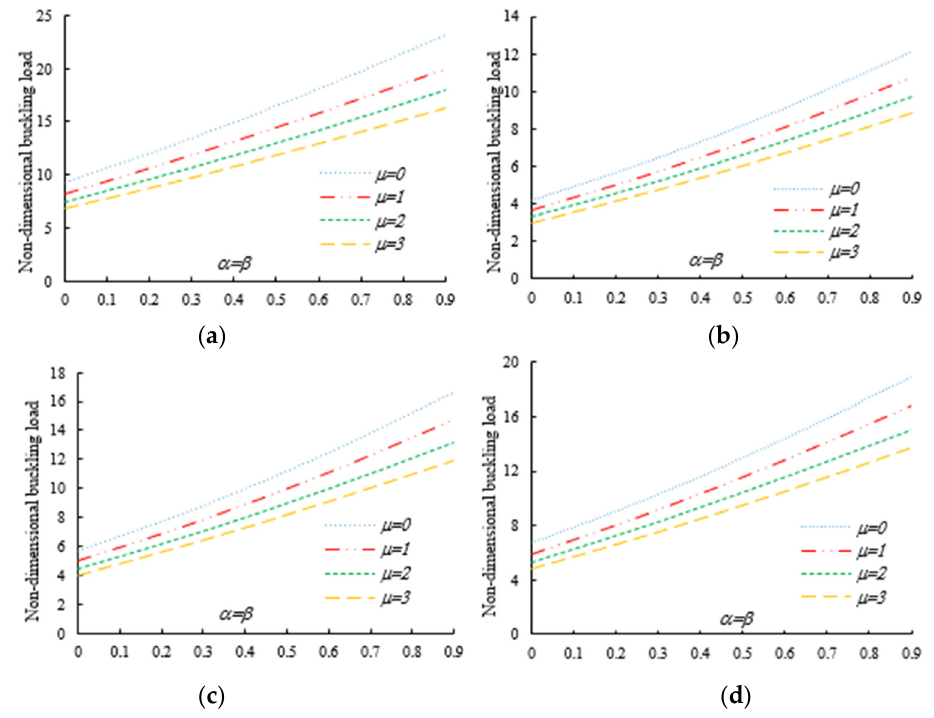
Figure 3. Variation in the flexural–torsional buckling load ( P nor ) of I-tapered nanobeams with varying tapering and nonlocality parameters—Figure 2. Effect of the axial load eccentricity, material graduation and tapering parameter on the normalized buckling load P nor for simply supported thin-walled nanobeams subjected to a constant compressive load with two different nonlocal parameters: ( a )Homogeneous ( Alumina ) ; ( b ) m = 0.6; ( c ) m = 1.3; ( d ) m =